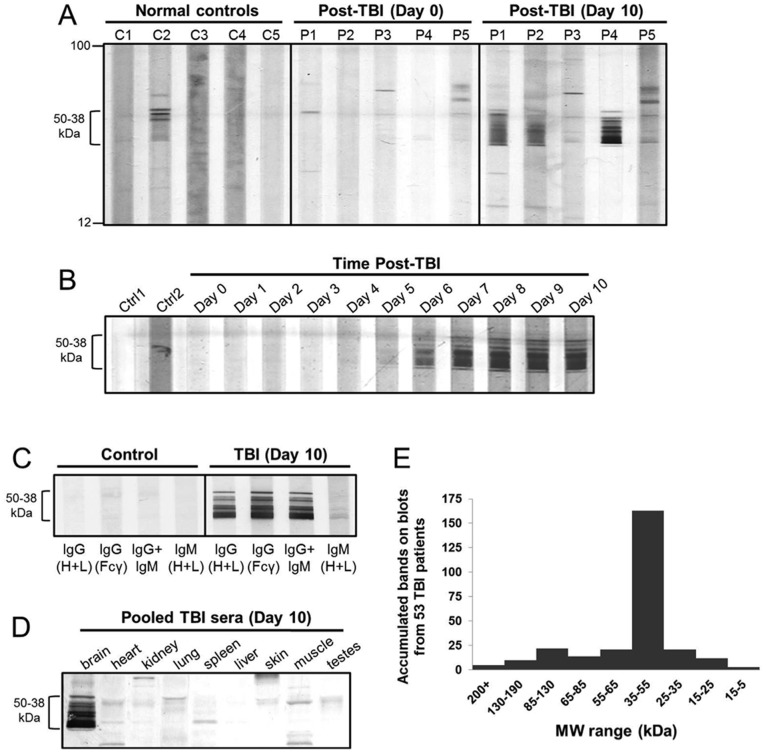
Human severe TBI patients developed circulating IgG autoantibodies against brain proteins within the 50-38 kDa range after injury.
A. An immunoblot of human brain lysate probed with sera from 5 normal controls (C1–C5) and 5 TBI patients (P1–P5), the latter at two time points post injury (Day 1 and Day 10). Sera were used at 1∶100 except TBI P4, which was 1∶2000. B. An immunoblot of human brain lysate probed with sera from 2 normal controls (Ctrl), or daily serum samples from a strongly immunoreactive TBI patient (Days 0–10 post TBI). C. An immunoblot of human brain lysate probed with control or TBI serum (Day 9), and then developed with secondary antibodies against human IgG or IgM. D. Lysates from a panel of human organs probed with pooled TBI sera (Day 10; n = 4). E. Sera from 53 TBI patients (Day 4–10) blotted individually against human brain lysate. Lanes on blots were arbitrarily subdivided into 5 kDa increments using vision works LS image acquisition software. The total number of bands in all lanes were counted, summed and plotted according to MW.